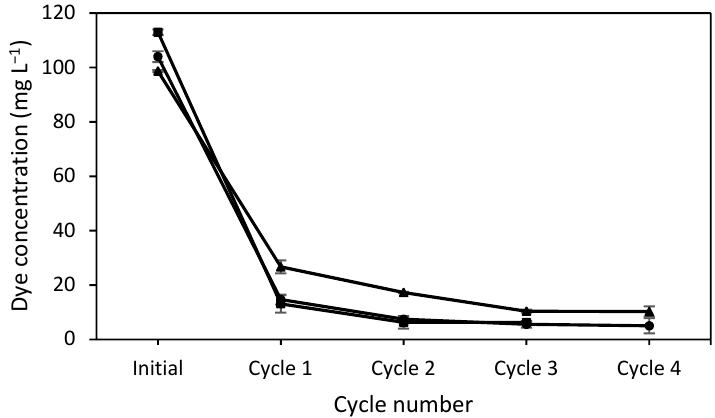
Figure 3. Variation of BBG concentration using T:D (1:1), ( ■ ), T:C (2:1), ( ) and T:M (1:1), ( ▲ ).